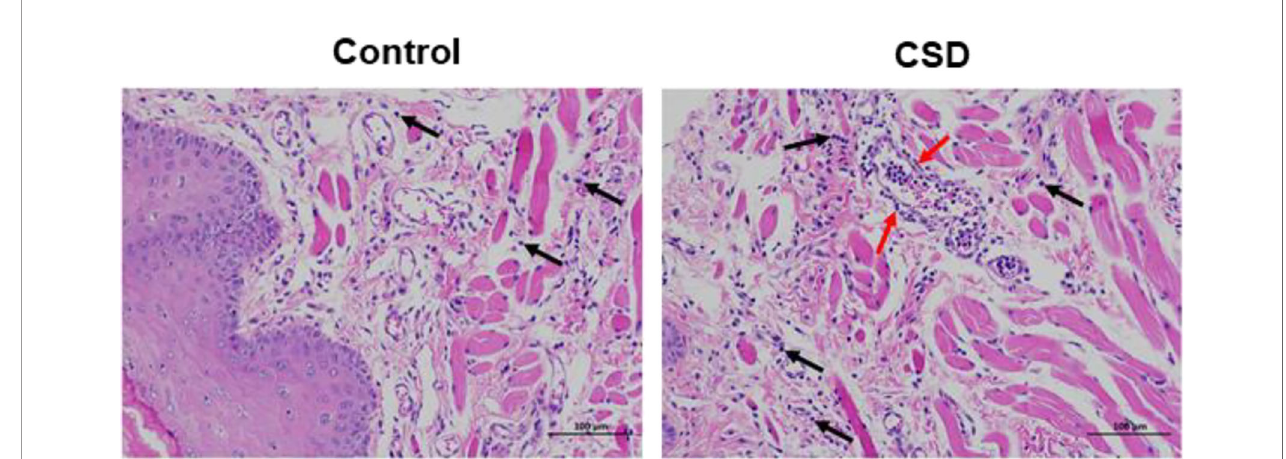
FIGURE 1 | The effects of CSD on buccal mucosa in rats (Mucosal histopathology changes in rats). The results showed a more serious in fl ammatory histological appearance compared to the control group. The pictures were taken at 200×. The black arrows indicate in fi ltration of in fl ammatory cells and the red arrows indicate a large number of leukocytes in the lumen of the vessel, and a ring of in fl ammatory cells in fi ltrating around the vessel.